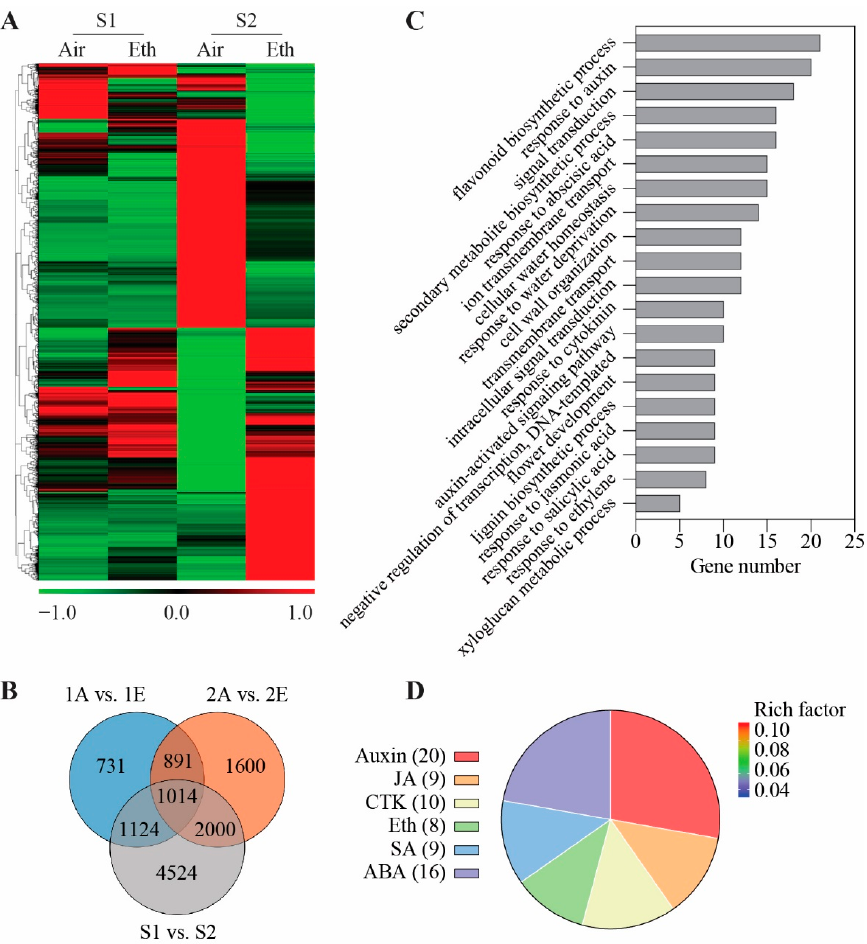
Figure 2. Screening of ethylene-responsive genes in rose petals. ( A ) Hierarchical clustering analysis of DEGs. Petals at stages 1 and 2 exposed to air and ethylene for 24 h. Log 10 of FPKM in each gene set was used to generate the cluster. Different shades of red, black, and green indicate the extent of the changes, in accordance with the color bar provided. ( B ) Venn diagram analysis of DEGs in different groups. 1, stage 1 (S1); 2, stage 2 (S2); A, air; E, ethylene. ( C ) Gene ontology functional classification analysis of the 2000 DEGs identified from Venn diagram. ( D ) DEGs related to hormone-signaling pathways. The numbers in the parentheses indicate the number of DEGs. Rich factor refers to the ratio of the number of DEGs located in GO term to all of the genes in the same term.